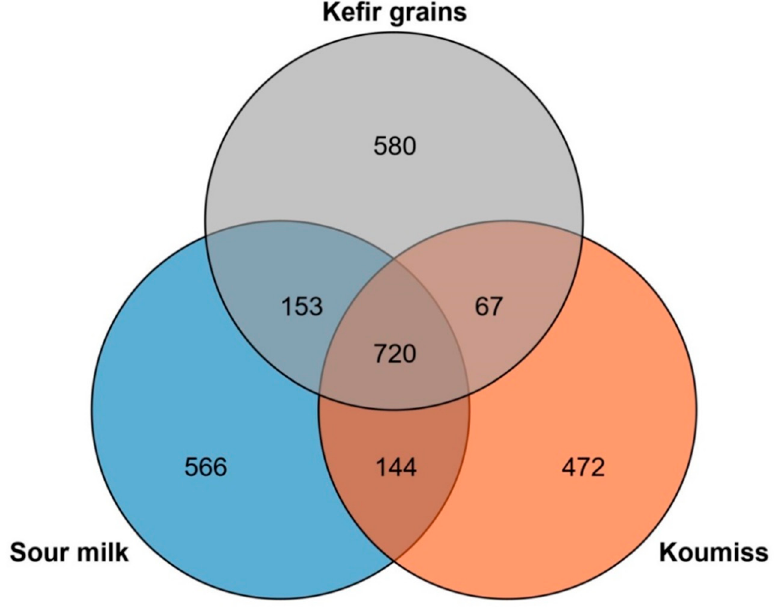
Figure 6. Venn diagrams of core gene sets of L. ke fi ranofaciens strains isolated from di ff erent